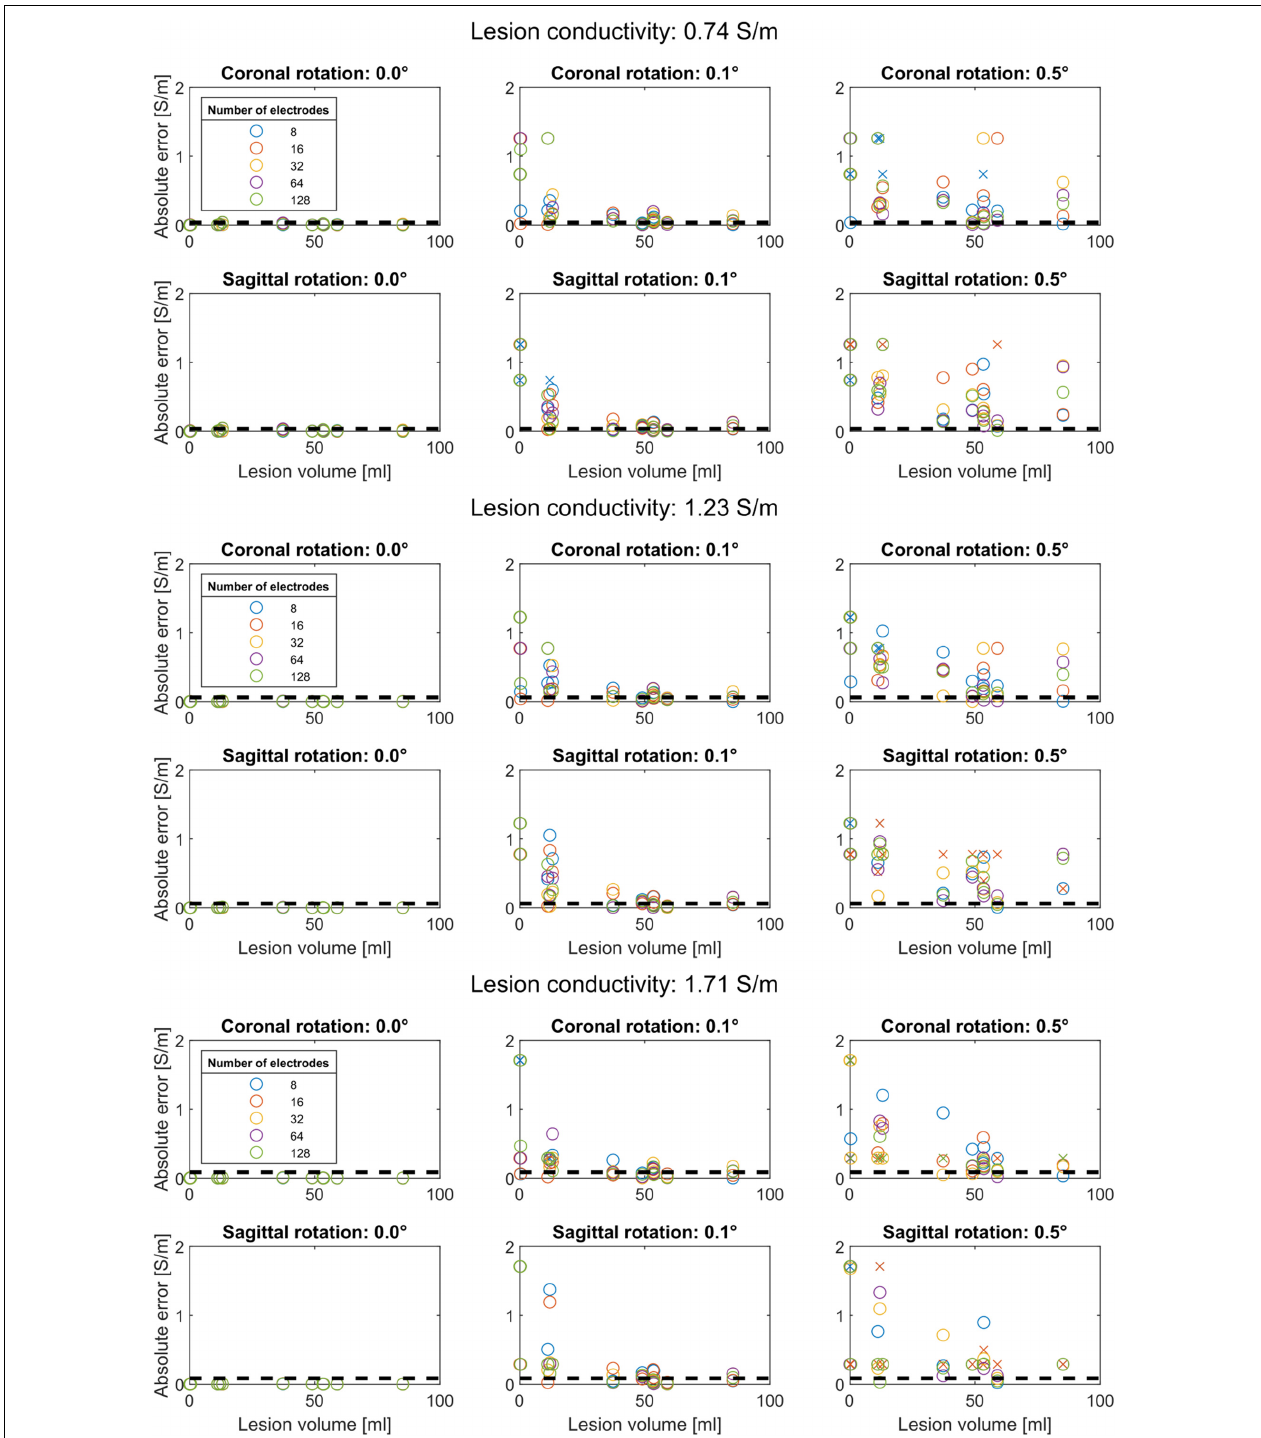
FIGURE 3 | Conductivity estimation accuracy for coronal rotation (first row) and sagittal rotation (second row) for a lesion conductivity of 0.74, 1.23, and 1.71 S/m. Each color represents a different subset of electrodes. The black dashed lines indicate a 5% relative error to the modeled conductivity. Conductivity estimations that did not converge are marked with an “x”. Each panel shows that the absolute conductivity estimation error ( y -axis) reduces with increasing lesion volume ( x -axis) for rotations up to 0.5 ◦ . Without electrode rotation (left column), the conductivity is correctly estimated regardless of lesion size. At the lowest lesion conductivity (0.74 S/m), the estimation procedure is more sensitive to coronal and sagittal electrode rotation, as reflected by larger absolute errors, compared to higher lesion conductivity (1.23 and 1.71 S/m).